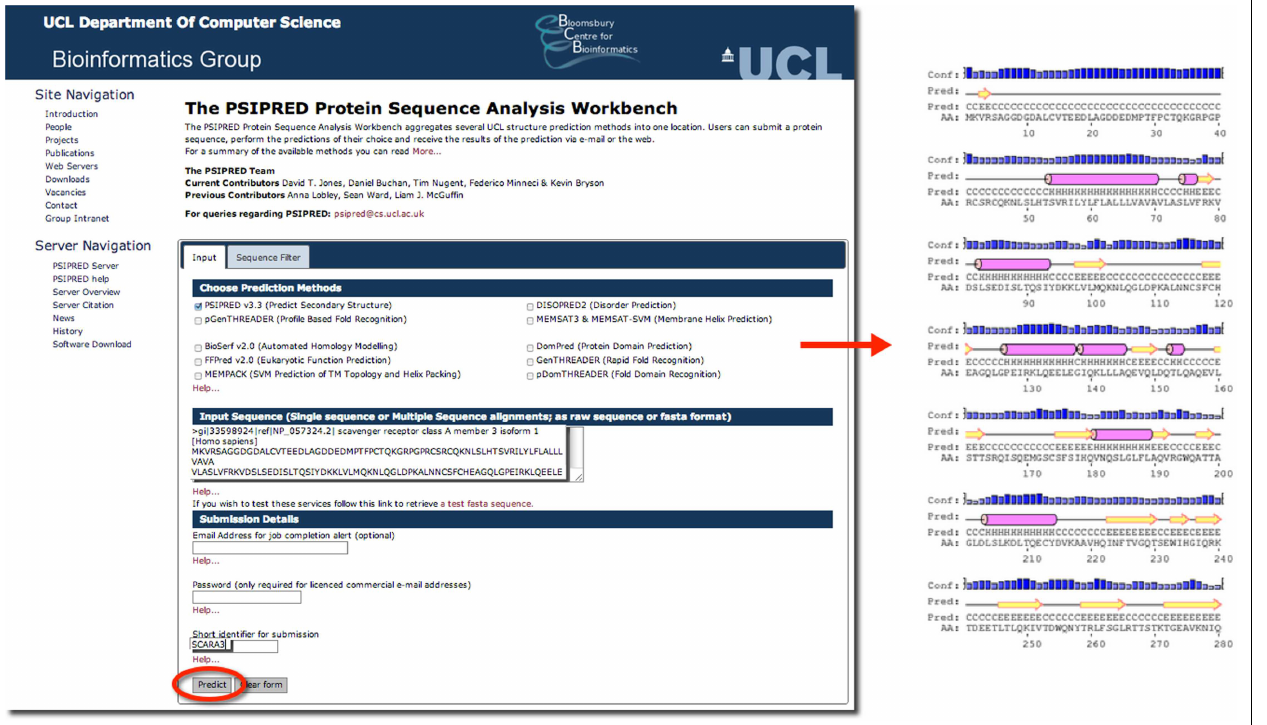
FIGURE 5 |The use of Psipred for the prediction of the secondary protein structure of SCARA3 .The Psipred tool combines various secondary protein prediction algorithms into one web-interface. Upon inputting the NCBI RefSeq